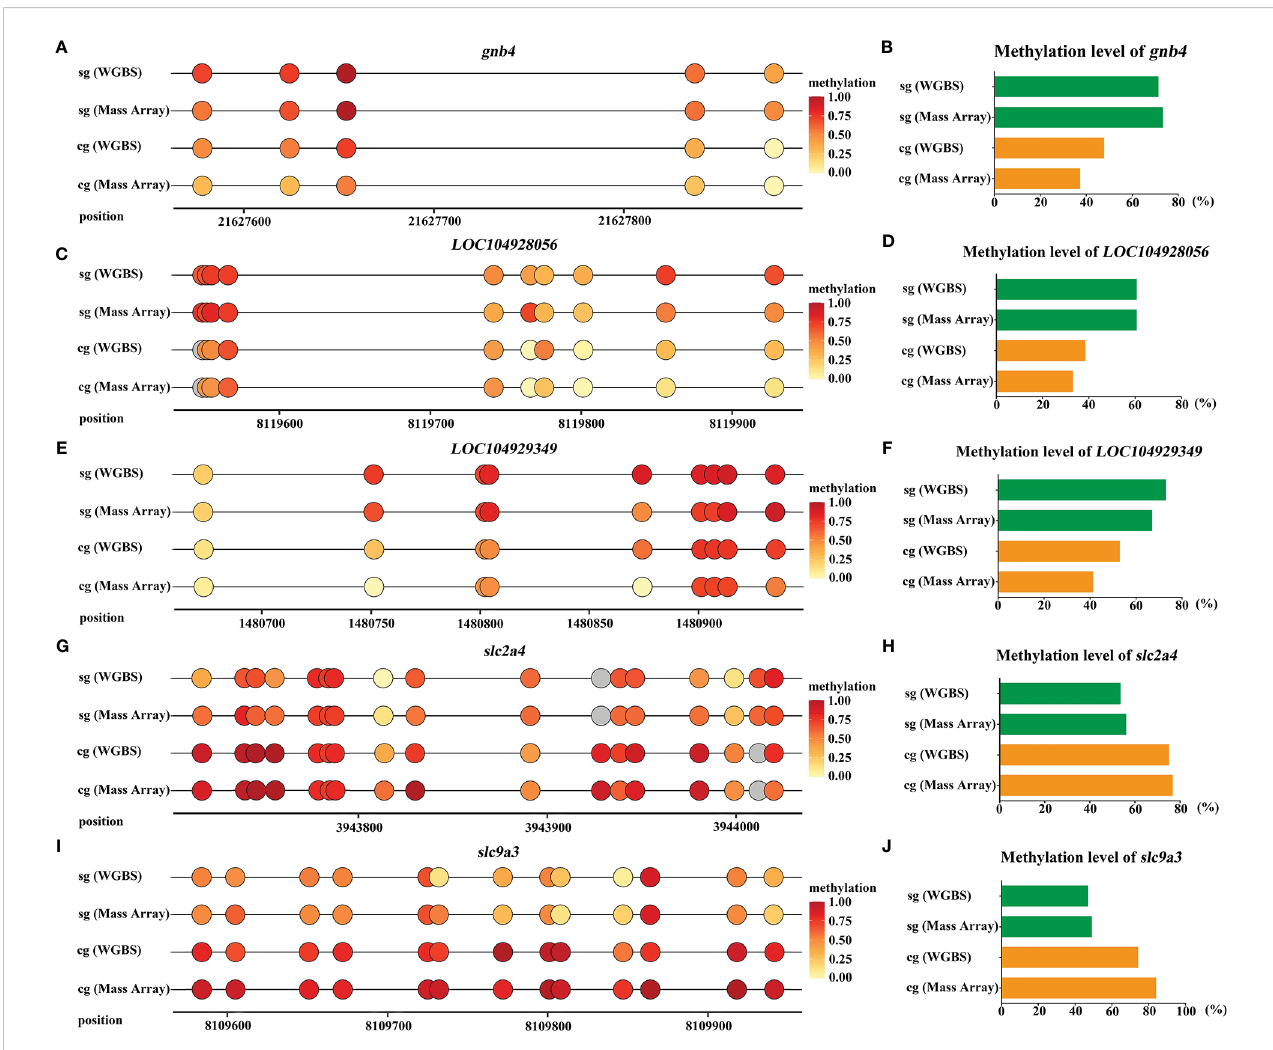
FIGURE 9 Validation of DMGs in gills of large yellow croaker under low-salinity stress. (A, C, E, G, I) WGBS and Mass Array analyzes of the fi ve DMGs ( gnb4 , LOC104929349 , LOC104928056 , slc2a4 , and slc9a3 ) in gills of S-group and C-group, respectively; grey color represents the CG site is undetected; (B, D, F, H, J) the average methylation level of the CG sties in promoter region of the fi ve DMGs ( gnb4 , LOC104929349 , LOC104928056 , slc2a4 , and slc9a3 ),